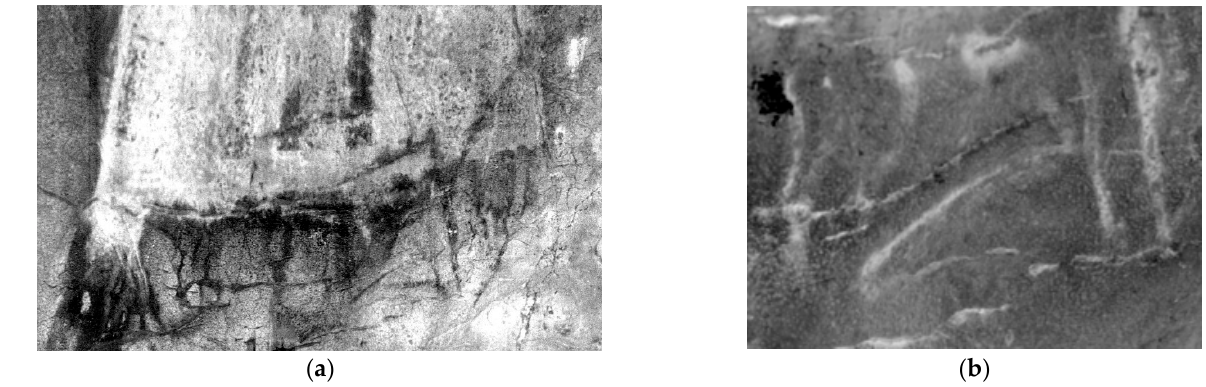
Figure 10. ( a ) Detail of the extraction of underlying pigments under the calcic crust and the ochre pigment as described in [2]; ( b ) left-facing hind head located at the bottom of the panel.